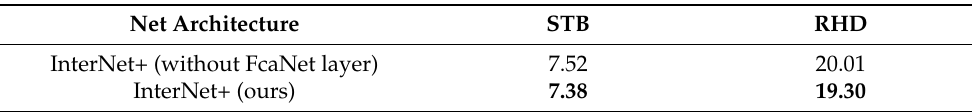
Table 7. Ablation experiment of the FcaNet module on different datasets (the number of training epochs in the ablation experiment is consistent with the training state of the complete network), the evaluation is measured by EPE